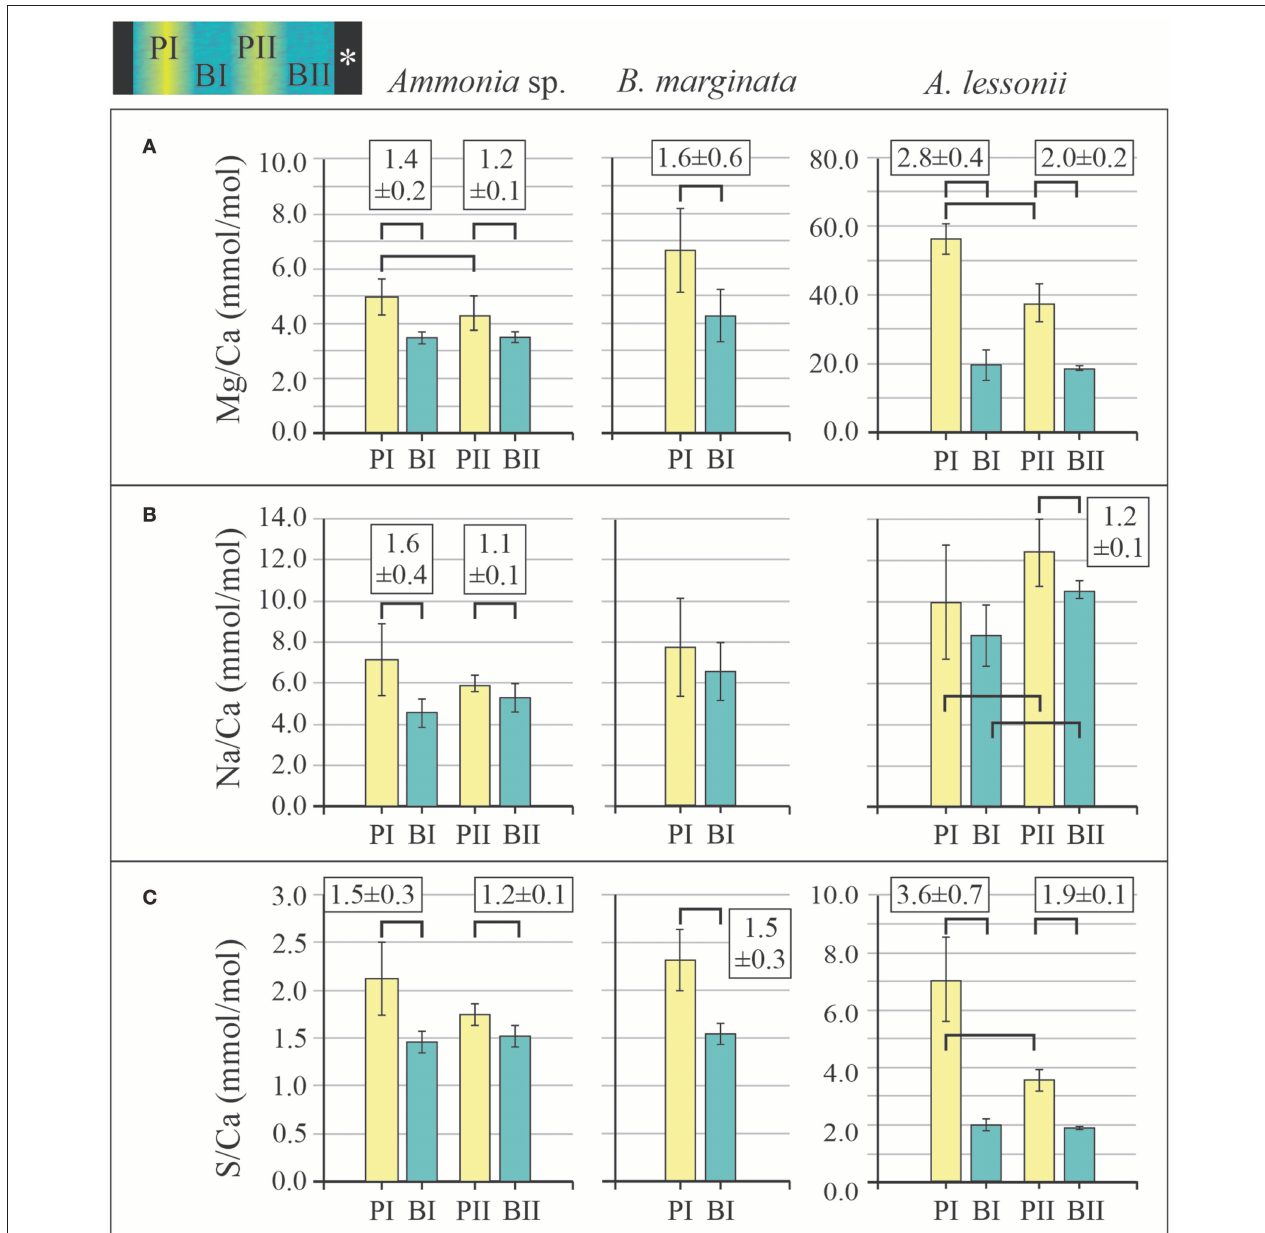
FIGURE 6 | EPMA average peak (E/Ca MAX ; yellow) and base (E/Ca MIN ; blue) values of primary peak and base (PI and BI) and secondary peak and base (PII and BII) for the three species Ammonia sp. T6 (left panels), Bulimina marginata (middle panels), and Amphistegina lessonii (right panels) for Mg/Ca EPMA (A) , Na/Ca EPMA (B) , and S/Ca EPMA (C) . Significant differences ( p < 0.05) between peak and base values (e.g., PI and BI) are indicated with black brackets, and for these values, peak factors ± SD (E/Ca MAX /E/Ca MIN ) are given (see also Table 3 ). For calculation of peak and base values, see paragraph 2.3.1. The top shows a hypothetical transect map with locations of PI, BI, PII, and BII, with the asterisk indicating the outer part of the test. Note that the scale of the y -axis is different for A. lessonii , except for Na/Ca. EPMA, electron probe microanalysis.